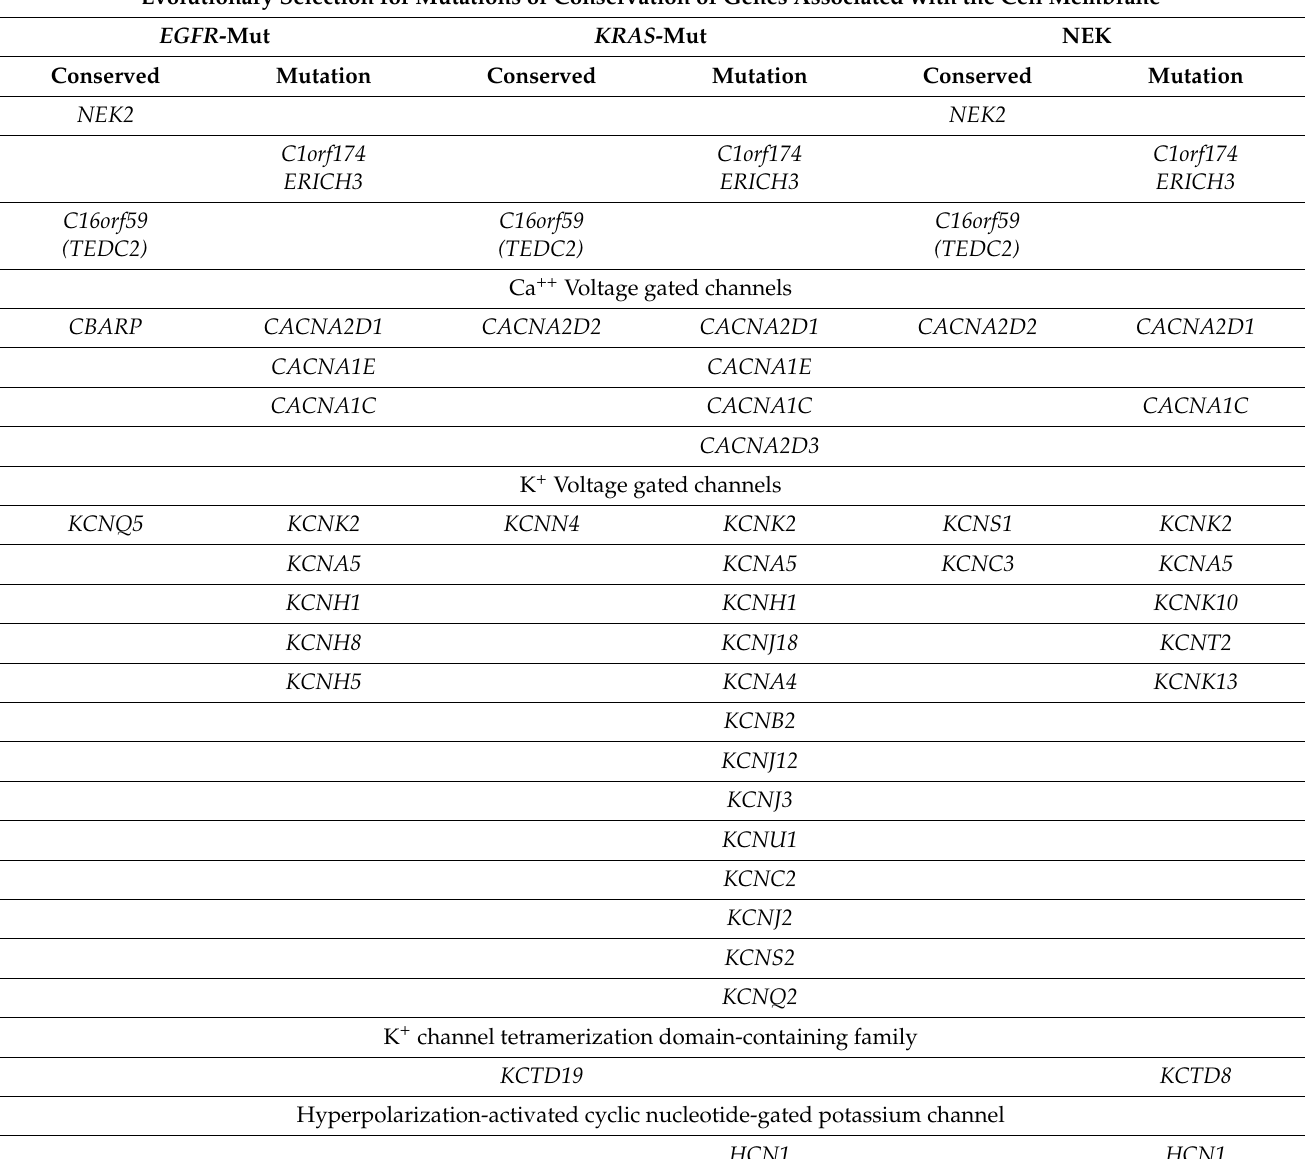
Table 4. Cont. Evolutionary Selection for Mutations or Conservation of Genes Associated with the Cell Membrane EGFR